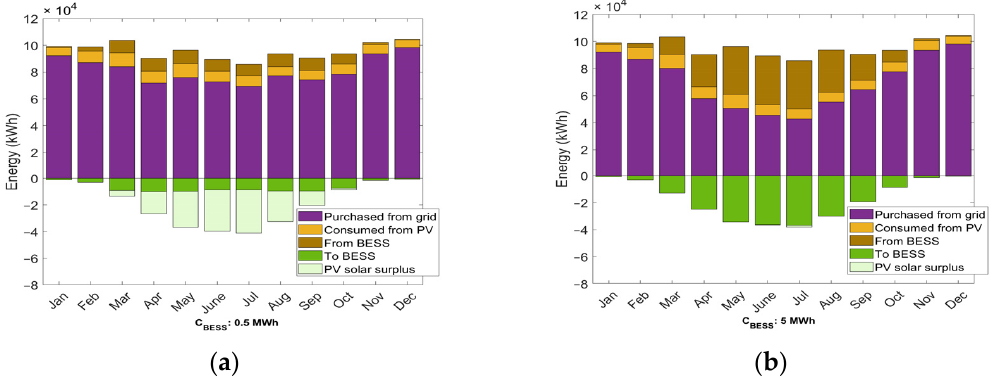
Figure 9. Monthly energy simulation results for scenario 2 using a BESS with a capacity of: ( a ) 0.5 MWh and ( b ) 5 MWh. The positive values on each graph represent the energy consumption from the grid, from solar, either directly, or via the BESS. The negative values indicate solar energy generation and energy storage in the BESS.